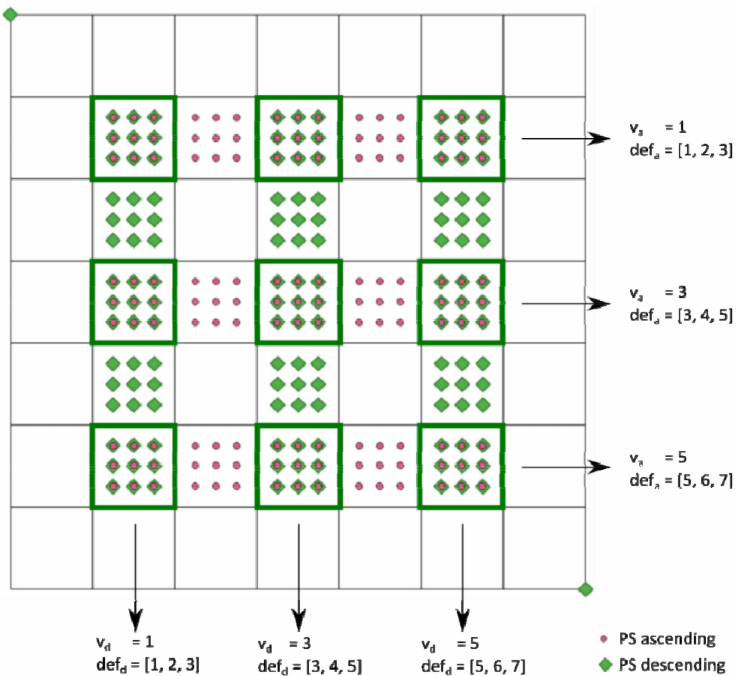
Figure 13. Synthetic dataset for los2hv. The green tiles are the only ones where both ascending and descending PS exist, and therefore, the unique areas where the horizontal component of the movement may be